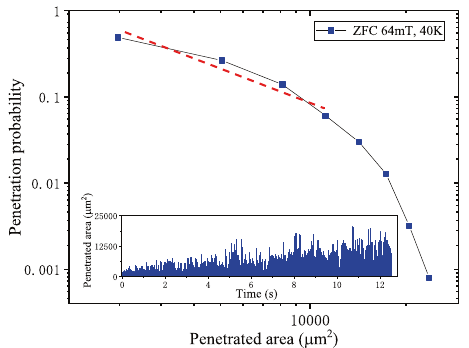
Fig. 6 Penetration probability of fl ux penetrated area. The curve corresponds to the statistics of the inserted penetration area with a time interval of 5 ms, where a straight line with a slope of − 1.43 ± 0.27 is added as a reference for visualisation.